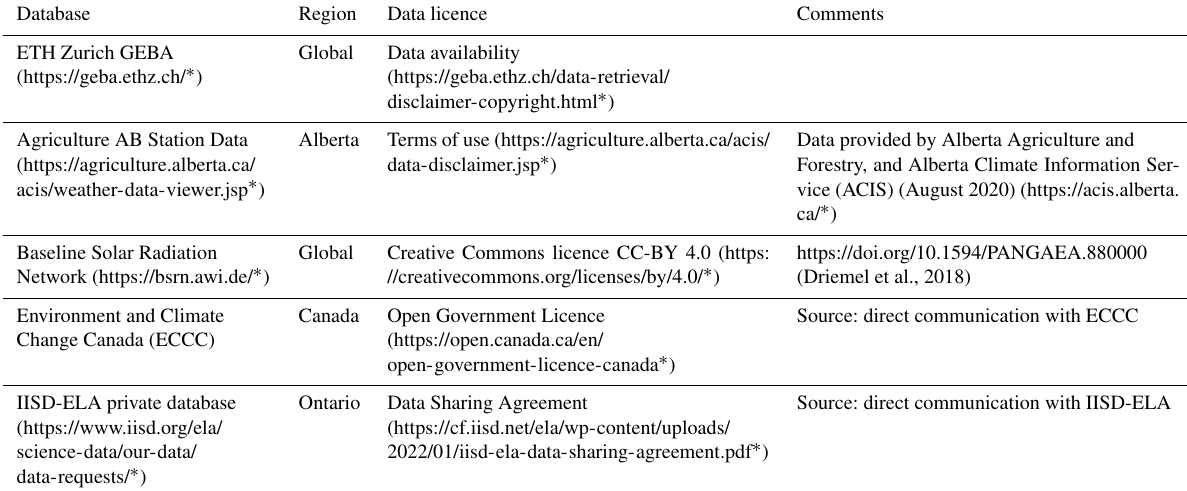
Table A2. Summary of sources and licensing for the surface solar radiation data. Direct links to the databases are provided where possible, but the Environment and Climate Change Canada (ECCC) and IISD-ELA data were acquired through communication with the curators. ∗ Last access: July 2022.